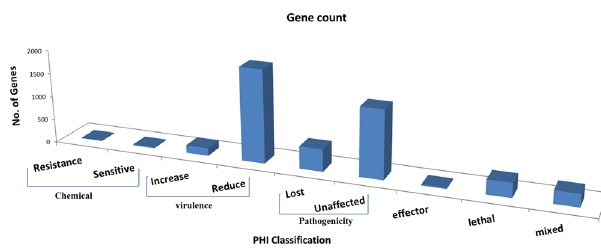
Figure 6. Distribution of A. rolfsii pathogenicity related genes in different